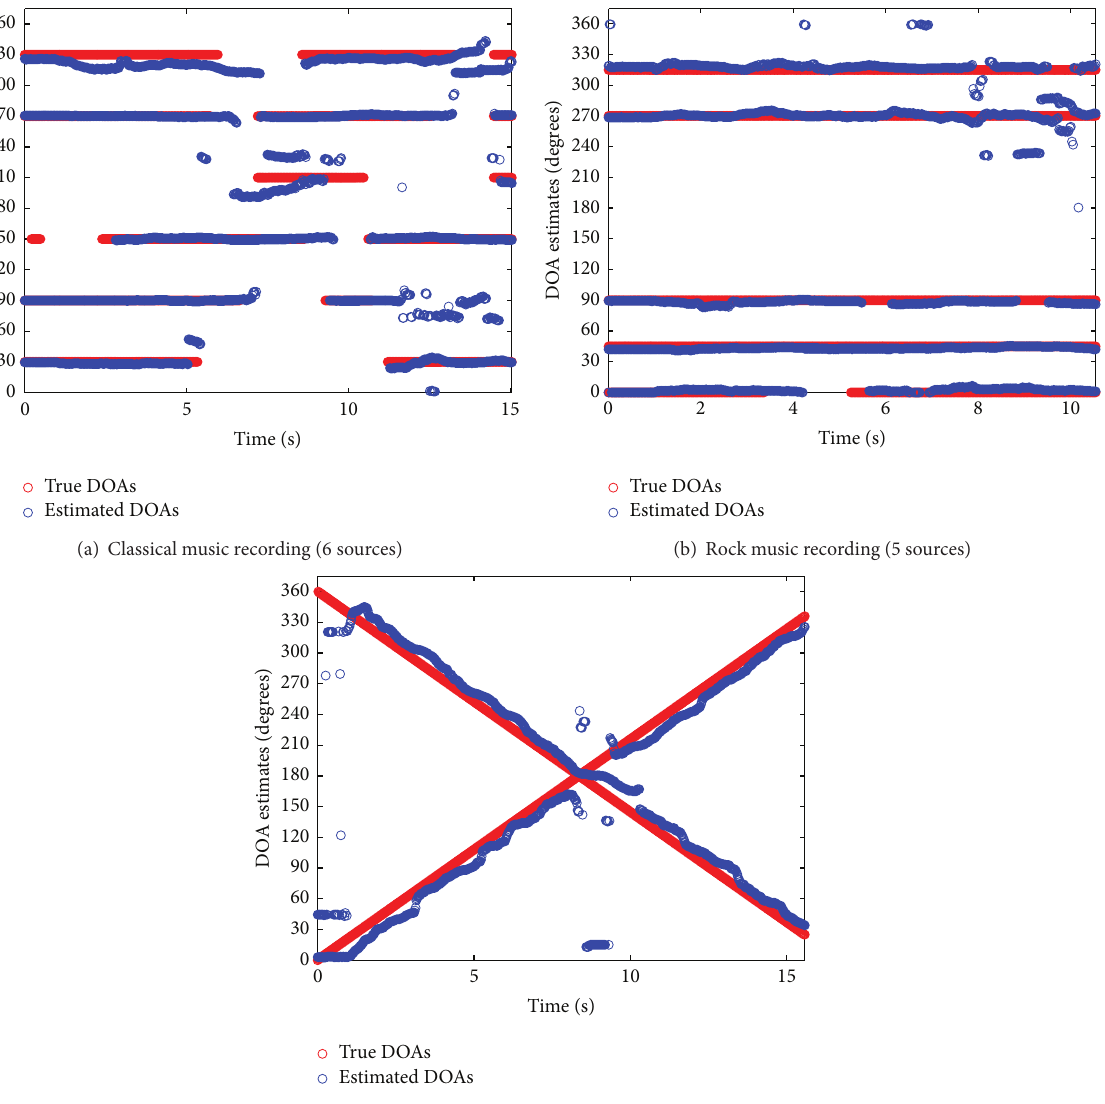
Figure 2: Estimated DOAs for the simulated microphone array